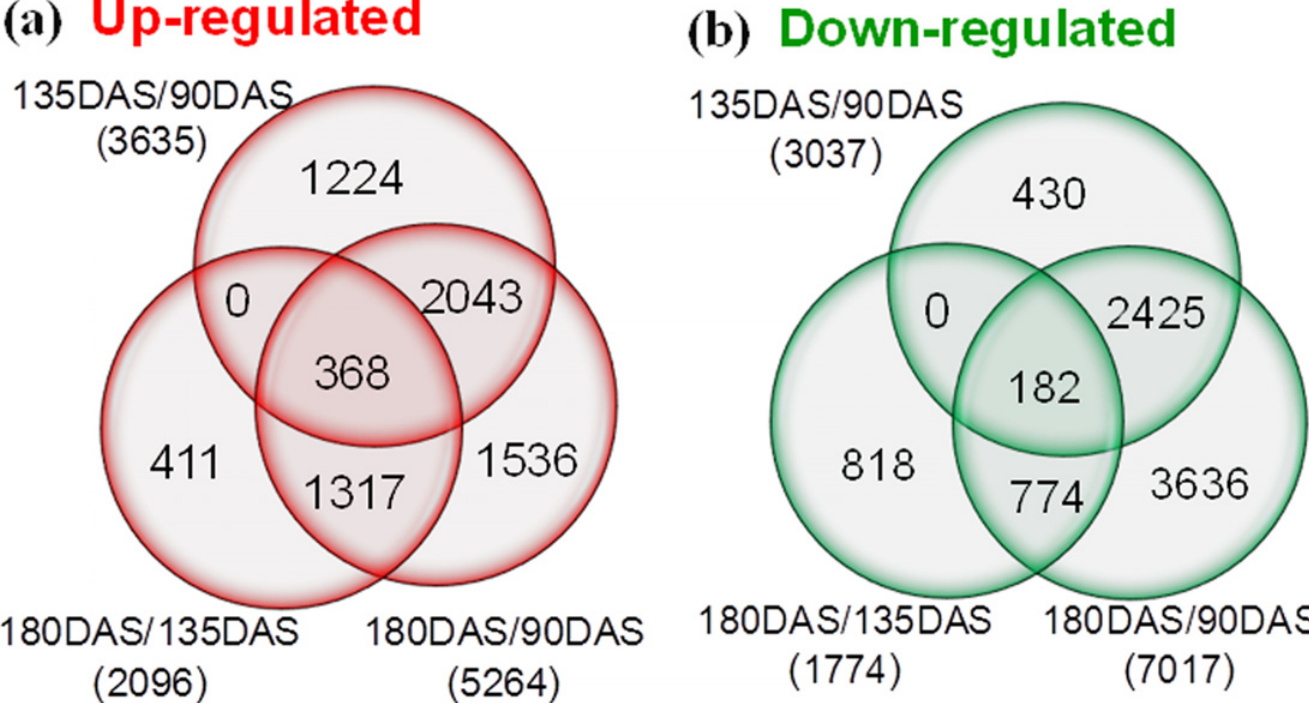
Fig 5. Venn diagram showing number of DEGs revealed by paired comparison (FDR (cid:1) 0.001, |log2FC| (cid:3) 1). The numbers of up- and down-regulated genes in comparisons of 135DAS/90DAS, 180DAS/135DAS/, and 180DAS/90DAS libraries. DEGs: Differentially expressed